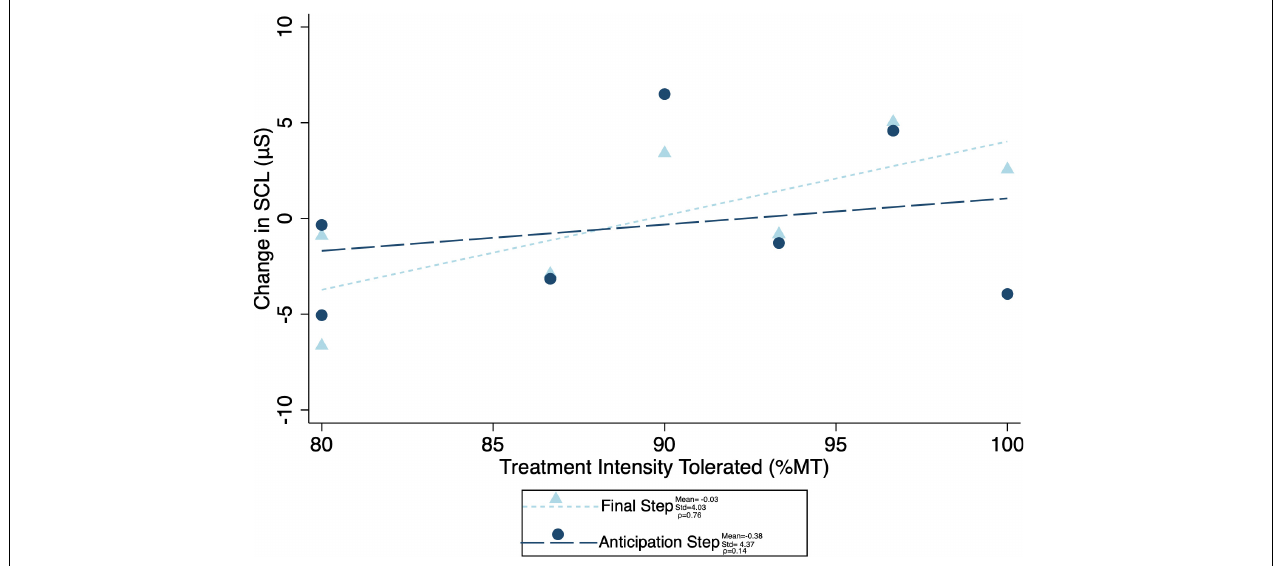
FIGURE 9 | Correlation between maximum treatment intensity tolerated and both anticipation step and mean final common step skin conductance level change (difference in mean skin conductance during the final step that was completed during both the pre- and post-treatment BATs). Change in SCL was calculated as pre minus post, with positive values indicating a decrease in SCL with treatment. Mean change in SCL, standard of deviation of the SCL change, and spearman correlation coefficient ( ρ ) for both anticipation and final common steps shown.